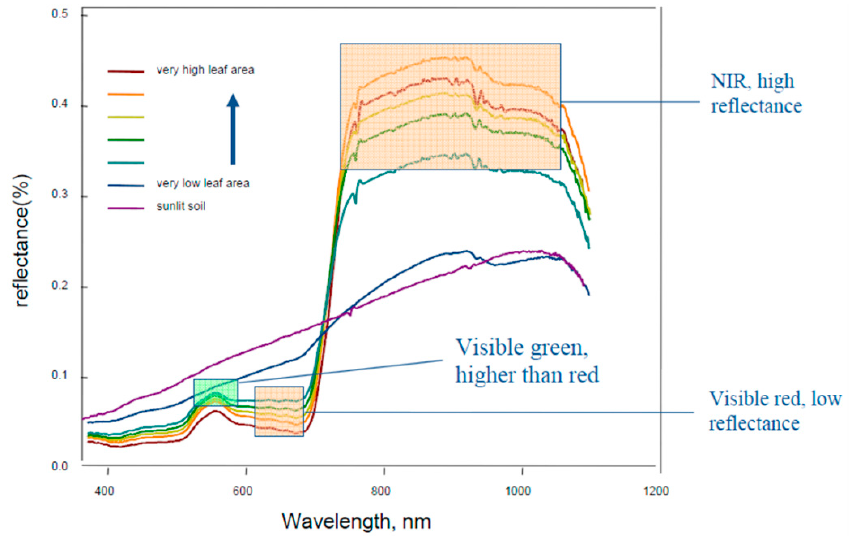
Figure 2. The light reflectance within the ranges (400 nm–1200 nm) of visible light and near infra-red.